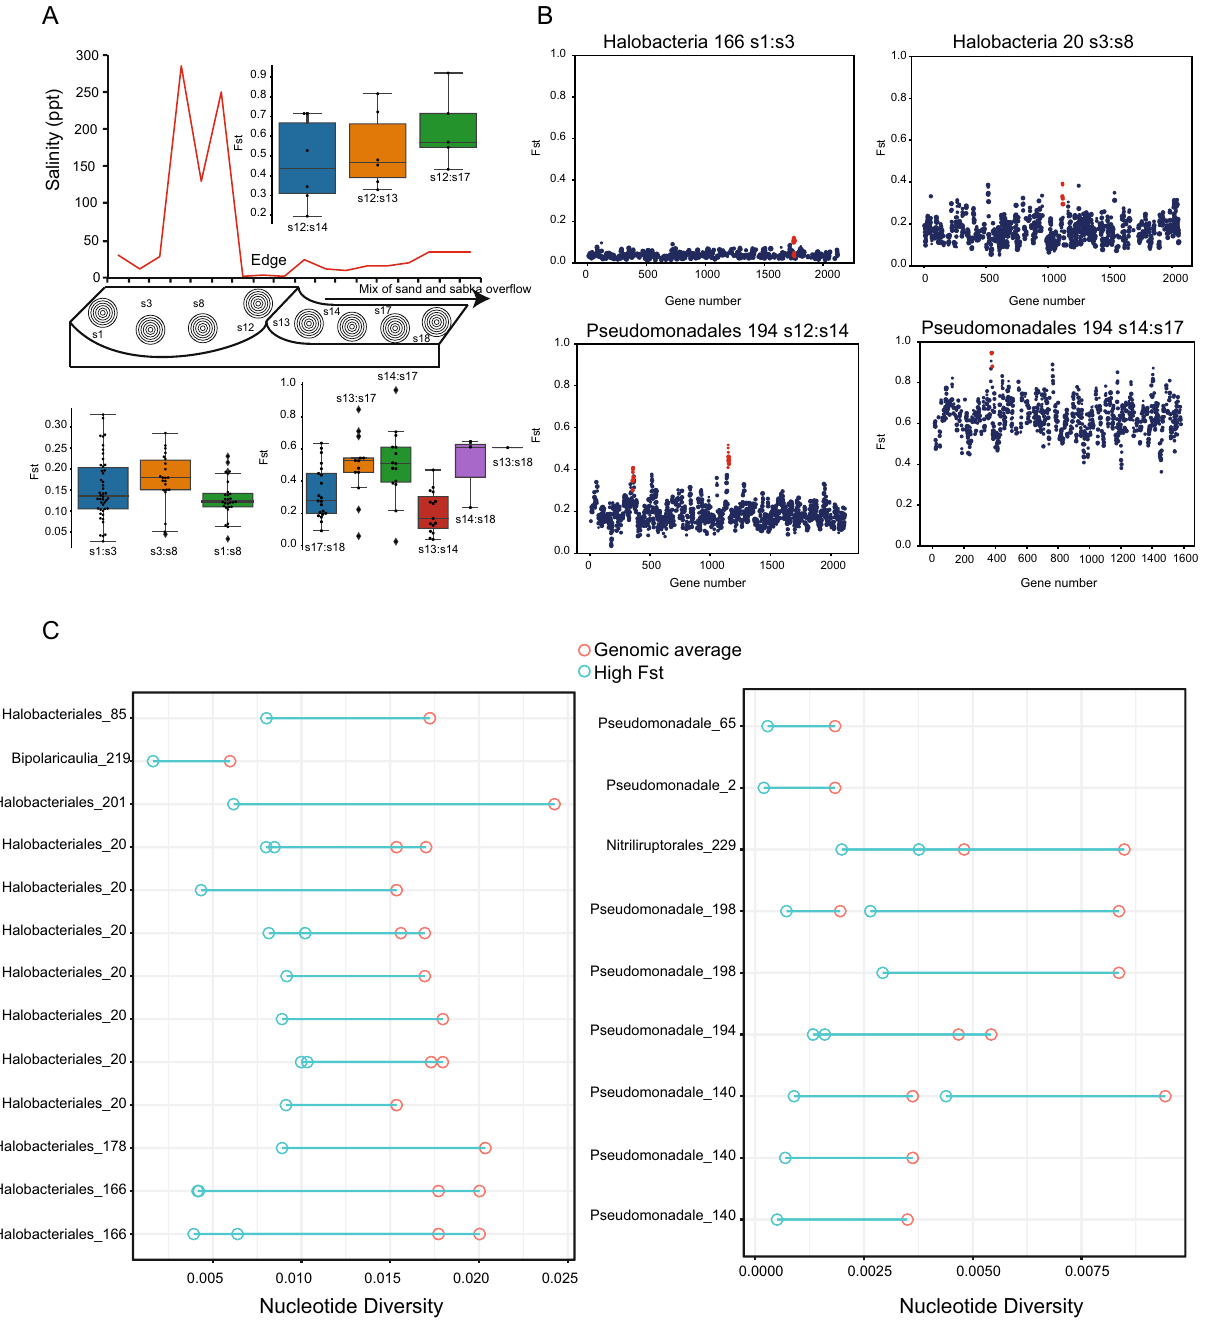
Figure 8. Population differentiation and gene selective sweep analysis. ( A ) Pairwise comparison of population differentiation (Fst) across the inner and outer sabkha along a salinity gradient (top panel). ( B ) Examples of Highly differentiated loci in inner and outer sabkha as well as across the edge. Plot of Fst for genes across the genomes of Halobacteriale and Pseudomonadale populations on the inner and edge/outside. The distribution of genes is represented by different points, as well as the size of the point is the number of SNPs for that gene. High Fst loci compared to the background are labeled in red. ( C ) Nucleotide diversity for the highest Fst loci (red circle) compared to the average genome (empty circle) for inner (left panel) and outer sabkha (right panel). Summary of gene selective sweep for some population is summarized in Supplementary Fig.